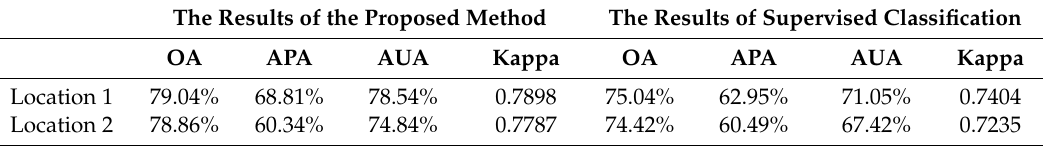
Table 2. Accuracy